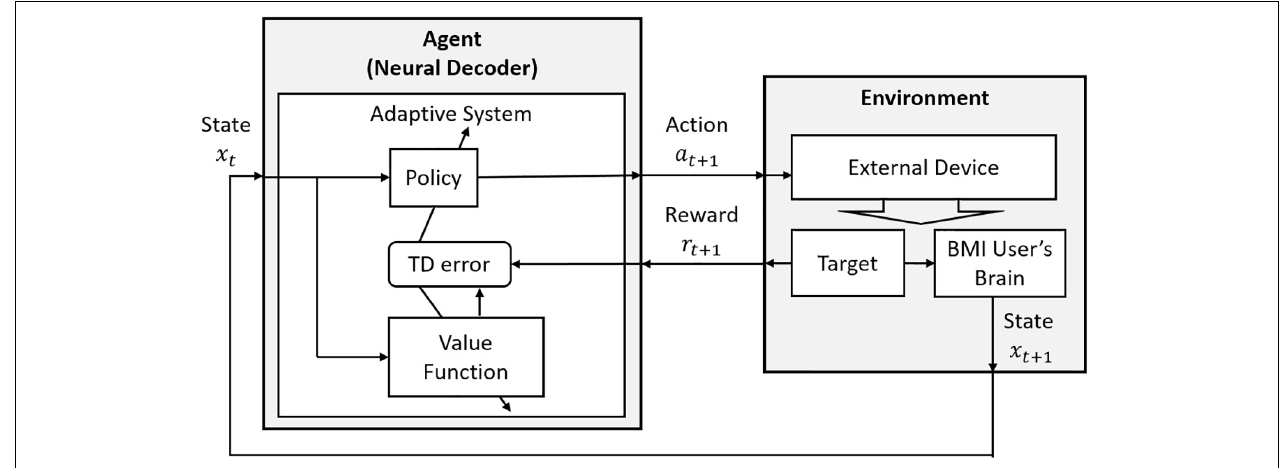
FIGURE 4 | The decoding structure of RLBMI using the Actor-Critic. This figure is modified based on Figure 6.15 in Sutton and Barto